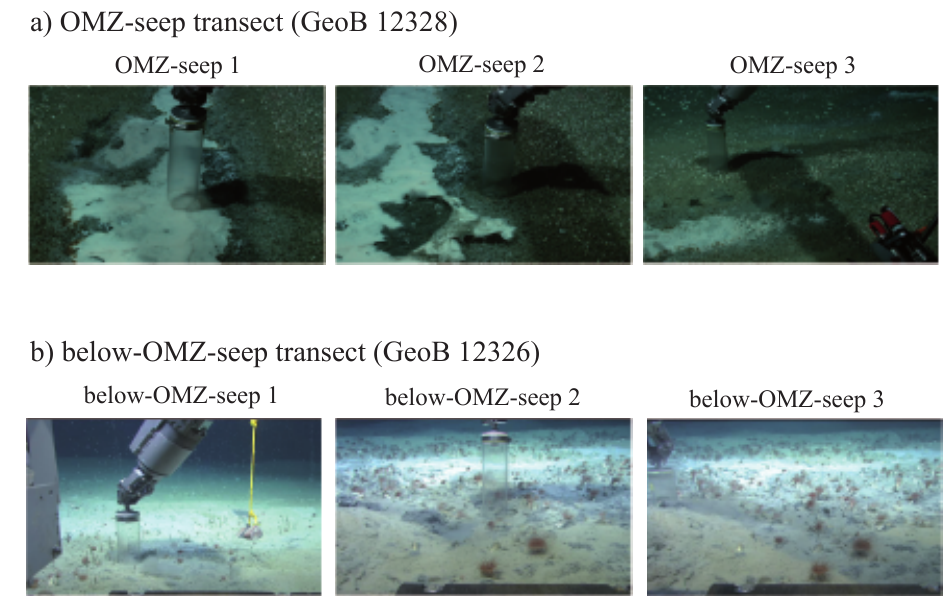
Fig. 2. High resolution photographs taken by the ROV QUEST 4000 showing the surrounding environment of the individual push cores retrieved along the two seep transects ( a) OMZ-seep (GeoB 12328), and specific samples OMZ-seep 1 (GeoB 12328-6), OMZ-seep 2 (GeoB 12328-2), and OMZ-seep 3 (GeoB 12328-4), ( b) below-OMZ-seep (GeoB 12326), and specific samples below-OMZ-seep 1 (GeoB